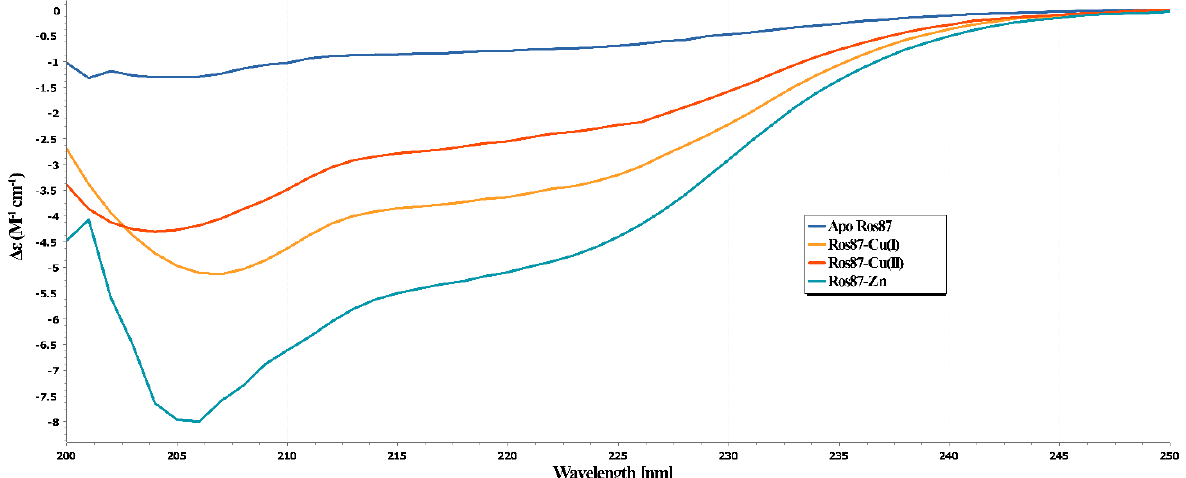
Figure 3. Far-UV CD spectra of Apo-Ros87 (blue line), Zn(II)-Ros87 (yellow), Cu(I)-Ros87 (orange), and Cu(II)-Ros87 (light blue). All of the spectra were acquired at 298K and normalized for concen- tration.